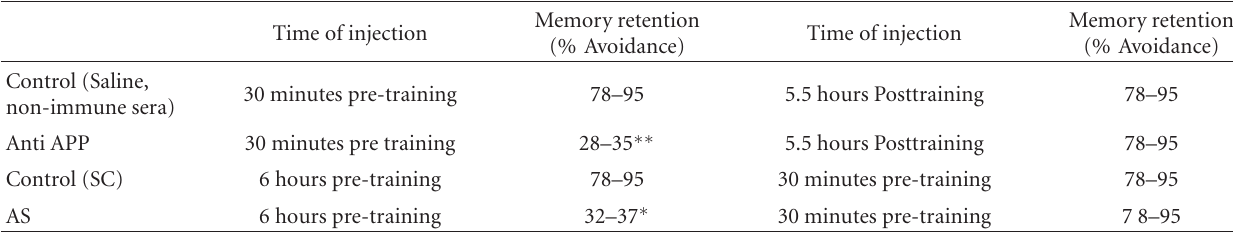
Table 2: E ff ect of anti-APP and APP antisense on memory retention.